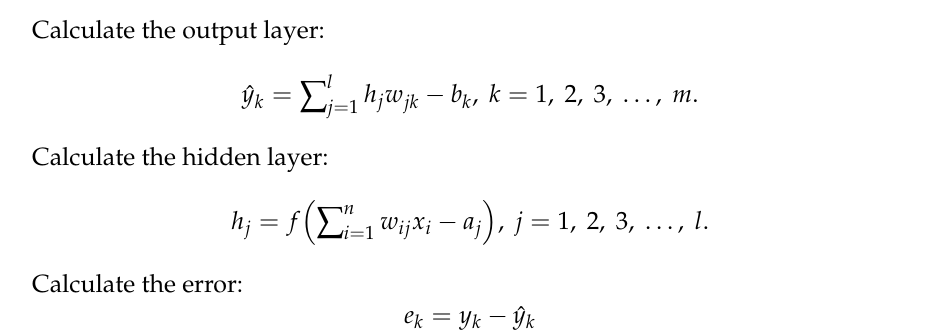
Figure 3. The training process of BP Neural Network.